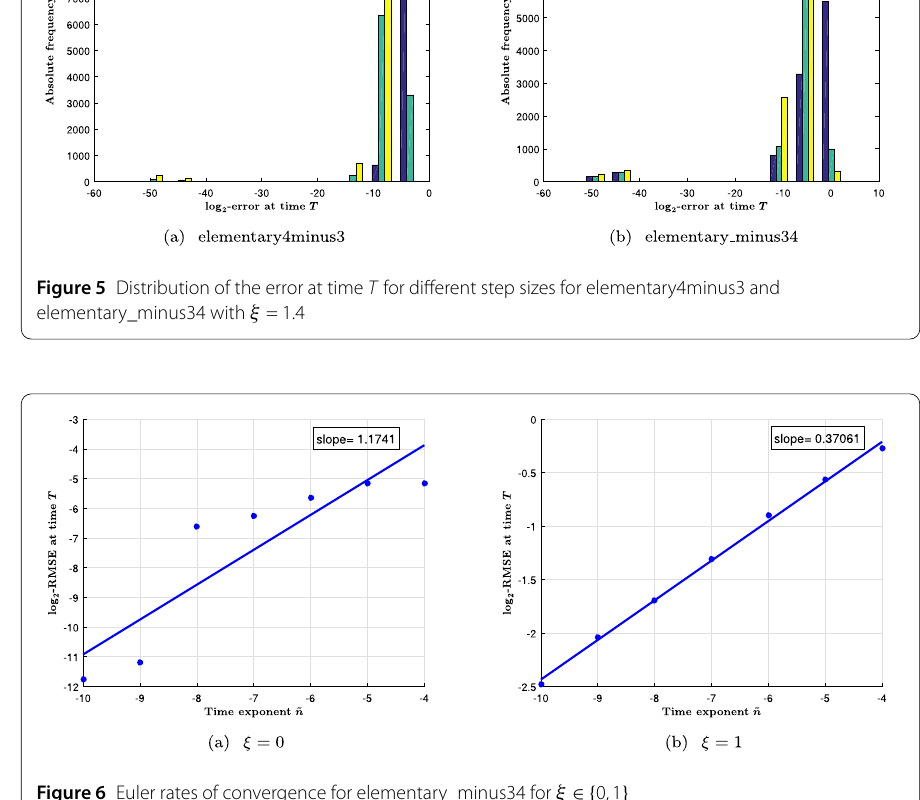
Figure 6 Euler rates of convergence for elementary_minus34 for ξ ∈ { 0,1